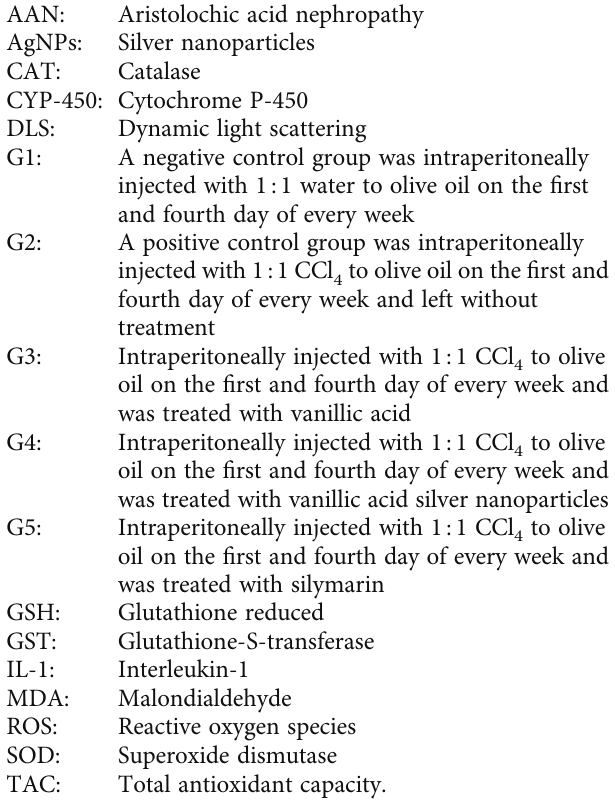
Table S1. E ff ect of treating CCl -induced nephrotoxicity in 4 male rats vanillic acid, vanillic acid AgNPs, and silymarin on serum electrolytes levels. Table S2. E ff ect of treating CCl -induced nephrotoxicity in male rats with vanillic acid, 4 vanillic acid AgNPs, and silymarin on malonaldehyde (MDA). Table S3. E ff ect of treating CCl -induced nephro- 4 toxicity in male rats with vanillic acid, vanillic acid AgNPs, and silymarin on serum IL-1 and CYP-450